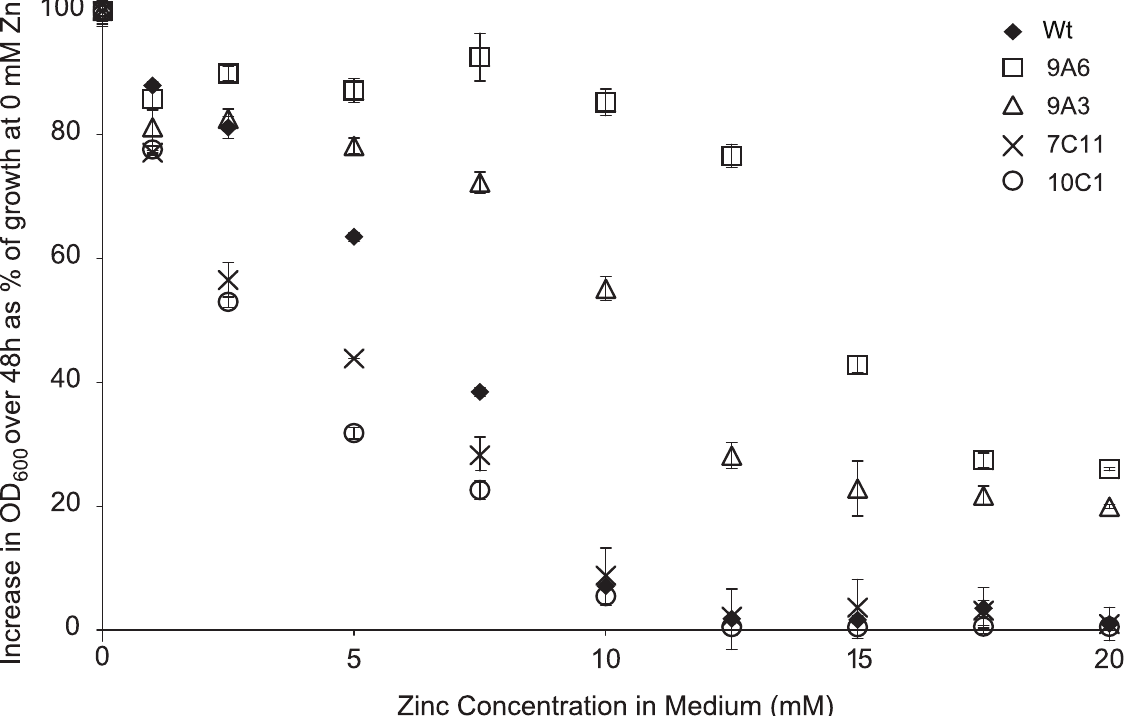
Figure 6. Zinc tolerance of P.syringae pv. maculicola M4 and four mutants. Five m l of bacterial suspension at an OD 600 of 0.2 were inoculated into 200 m l of KB broth supplemented with zinc at 0 to 20 mM. The graph shows the percentage increase in OD 600 48 hours after inoculation, relative to the increase in OD 600 over 48 hours observed for the same strain in the absence of zinc. At least four samples were analysed for each treatment. Values are means 6 SE ( n =8).